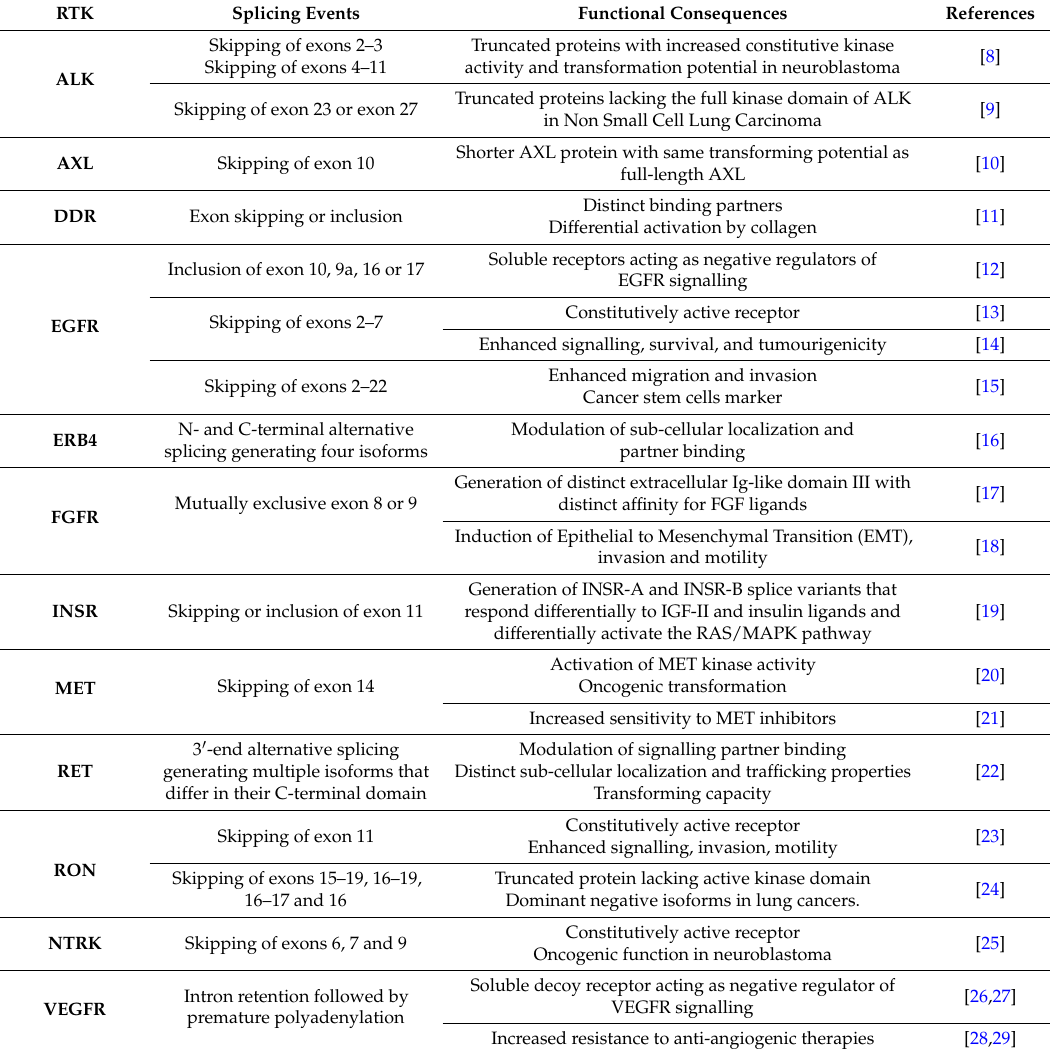
ALK: Anaplastic Lymphoma Kinase; DDR: Discoidin Domain Receptor; FGFR: Fibroblast Growth Factor Receptor; INSR: Insulin Receptor; RON: Receptor d’Origine Nantaise; NTRK: Neurotrophic Tyrosine Kinase